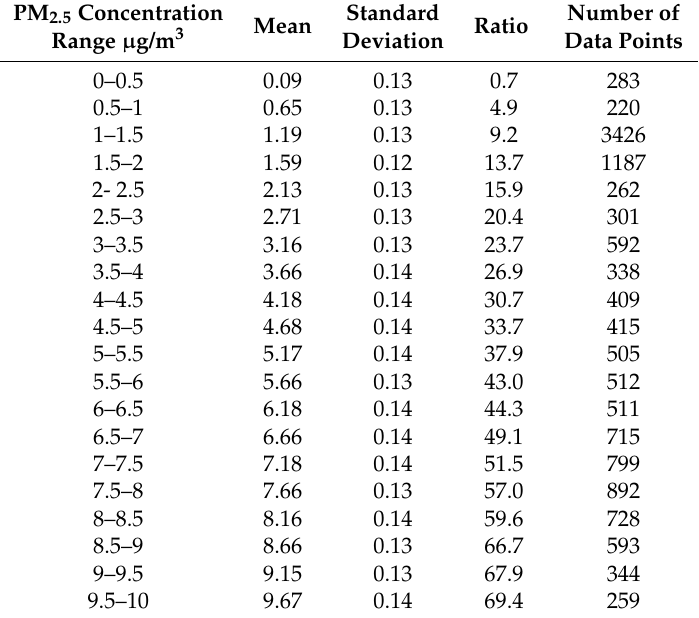
Table A2. PM 2.5 concentration range, the mean and the standard deviation of the PM 2.5 concentrations within that range, the ration of the mean and the standard deviation and the number of data points used for the calculations for Honeywell HPMA115S0. The Lower limit of detection with Wallace et al. [65] method is defined as the PM 2.5 concentration above which the ratio is > 3.